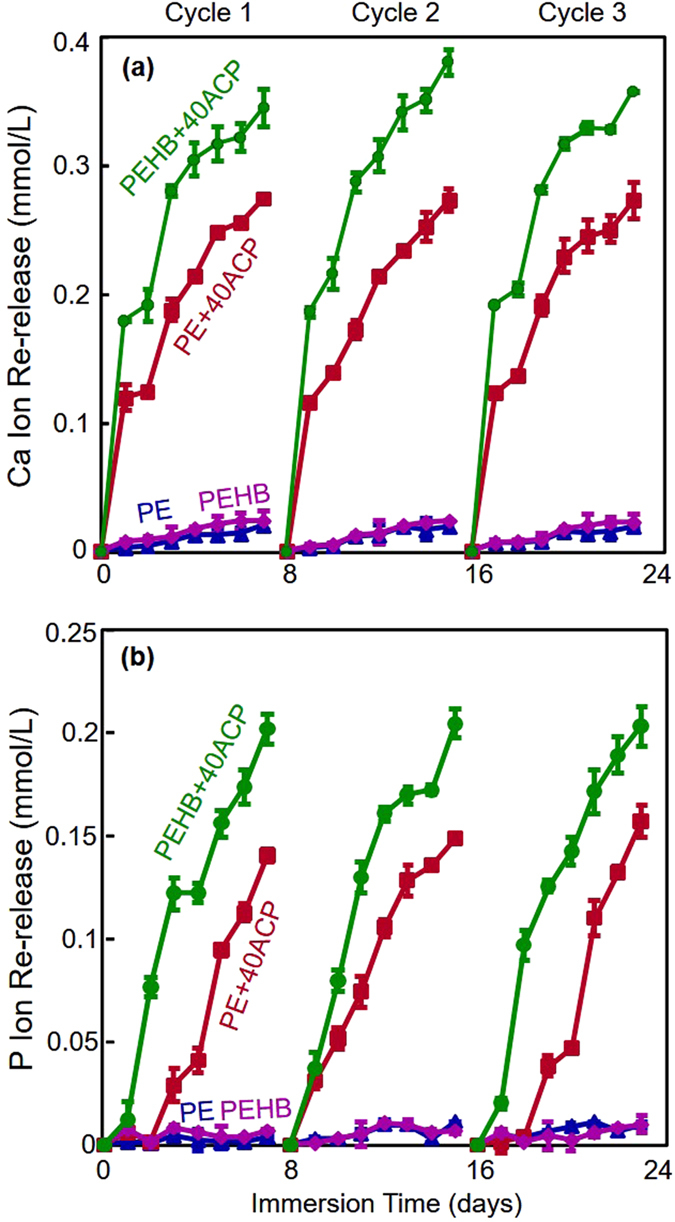
Ca and P ion recharge and re-release (mean ± sd; n = 3).(a) Ca ion re-release. (b) P ion re-release. Ca and P ion re-releases of PEHB+40ACP were significantly higher than those of PE+40ACP (p < 0.001). There was no decrease in the ion re-release level with increasing the number of recharge/re-release cycles from cycle 1 to cycle 3 (p > 0.1).